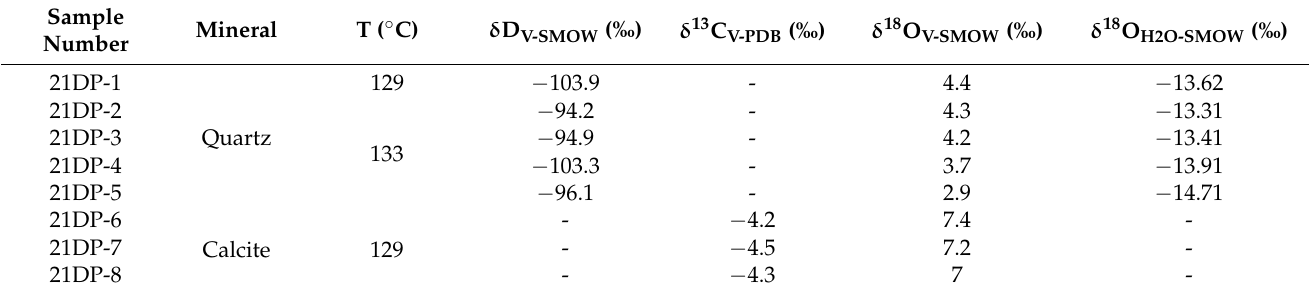
Note: The equilibrium temperatures for each stage are based on the fluid inclusion studies in this paper. The fractionation equation for δ 18 O water calculation: 1000ln α quartz − water = 3.38 × 10 6 /T 2 − 2.9 ([19]). The “-” in the table means no analytical results.